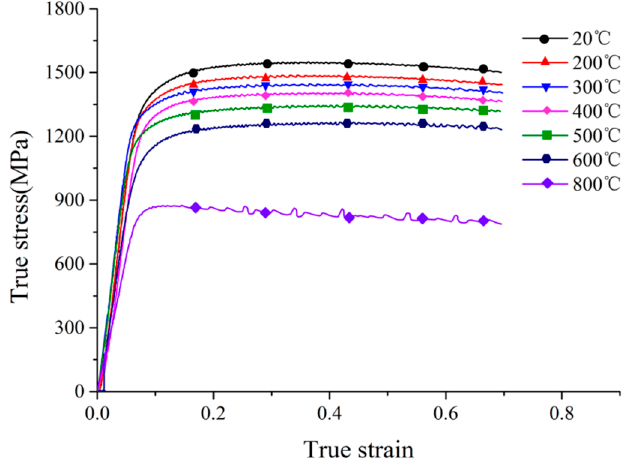
Figure 2. True-stress–true-strain curves at different test temperatures.